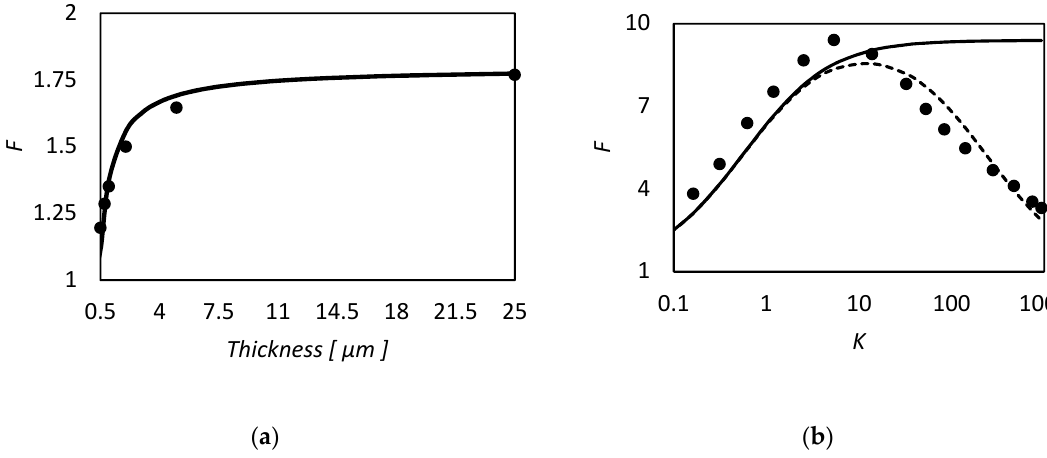
Figure 5. Model prediction of facilitated factor F. ( a ) Numerical results of Kutchai et al. [53] and Equation (101) calculations; ( b ) Asymptotic behavior of Equation (101) as function of dimensionless equilibrium constant ( K = K eq C A 0 ). Symbols are numerical results from Kemena et al. [7], filled line is Equation (101), dotted line is the improved model of Jeema and Noble, Equation (126).